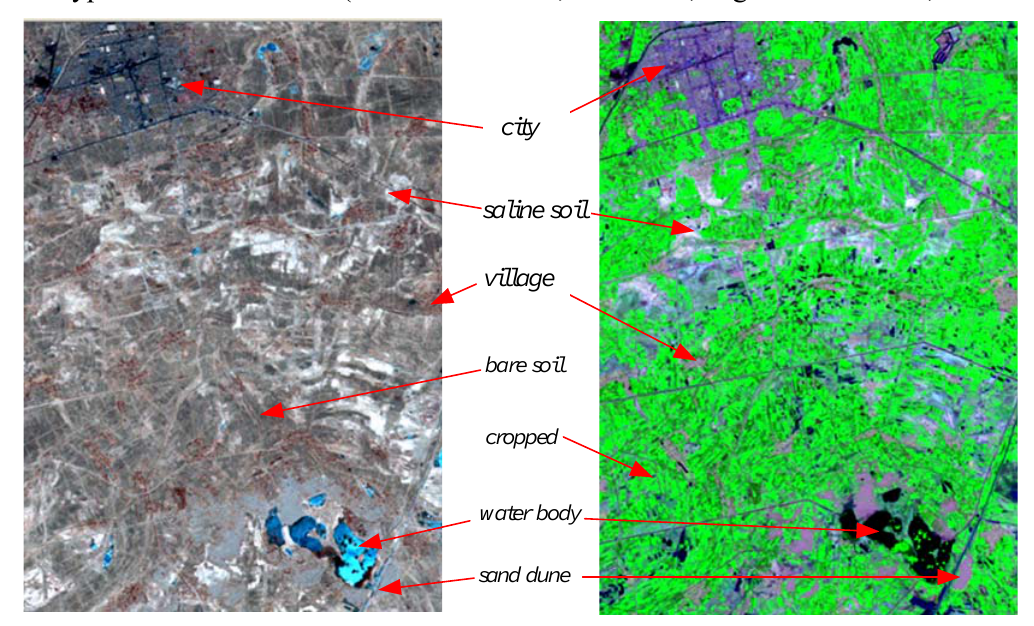
Figure 2. Typical terrain features (Left: 2001-03-11, Band 432; Right: 2001-08-02, Band